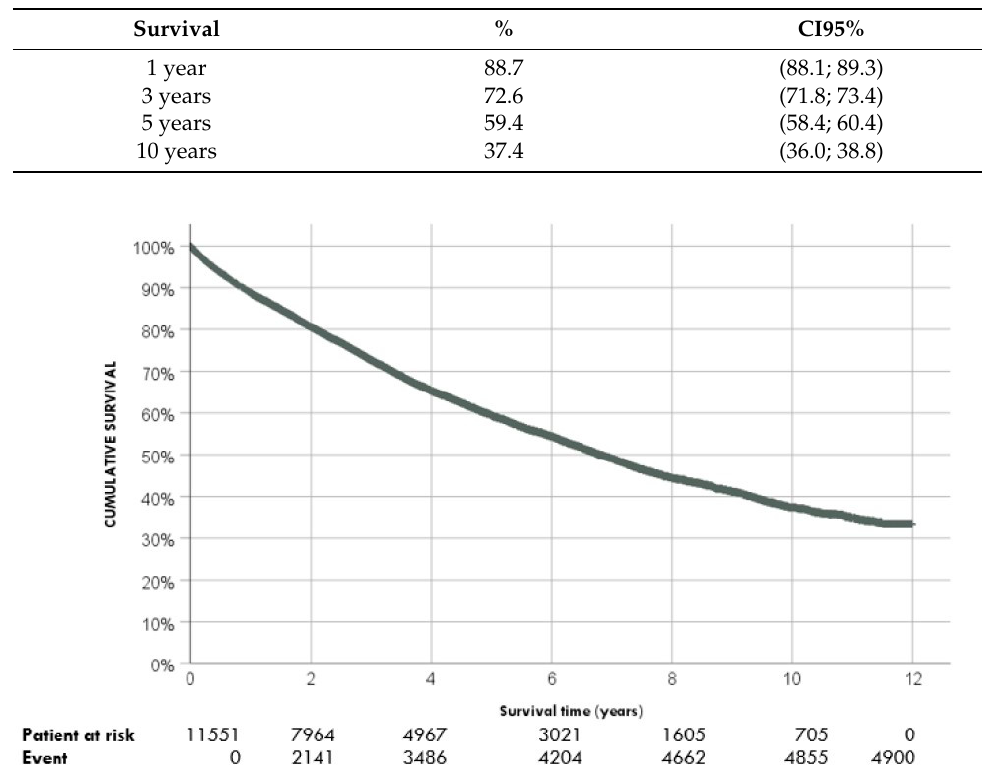
Table 2. Survival of incident patient in RRT.